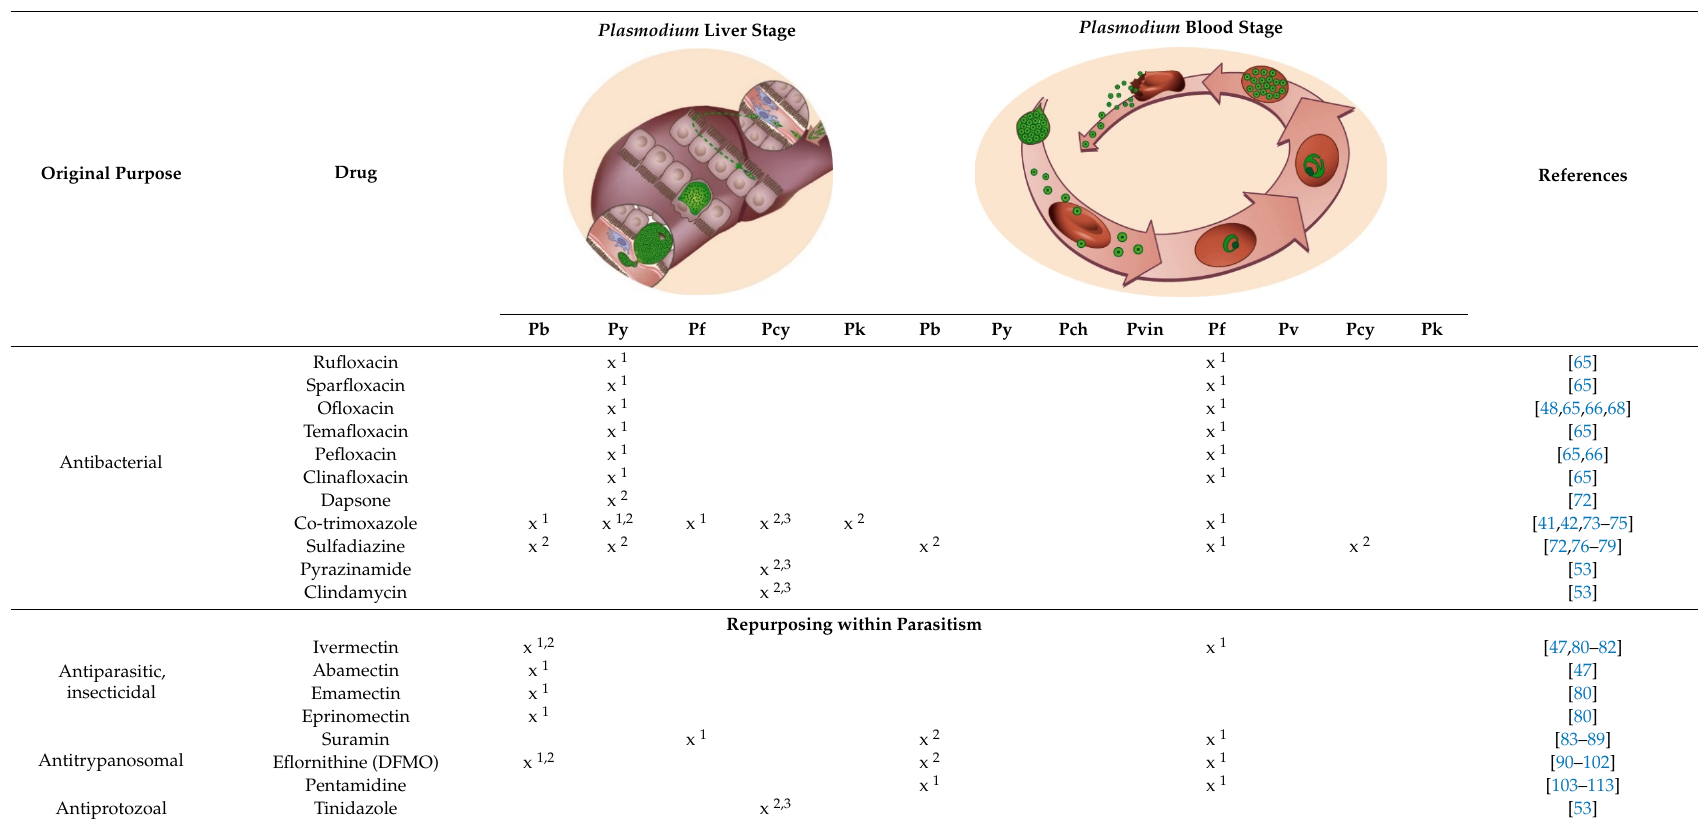
Table 1. Cont . Table 1. Summary of drugs that have been tested against the liver and/or blood stages of Plasmodium infection.